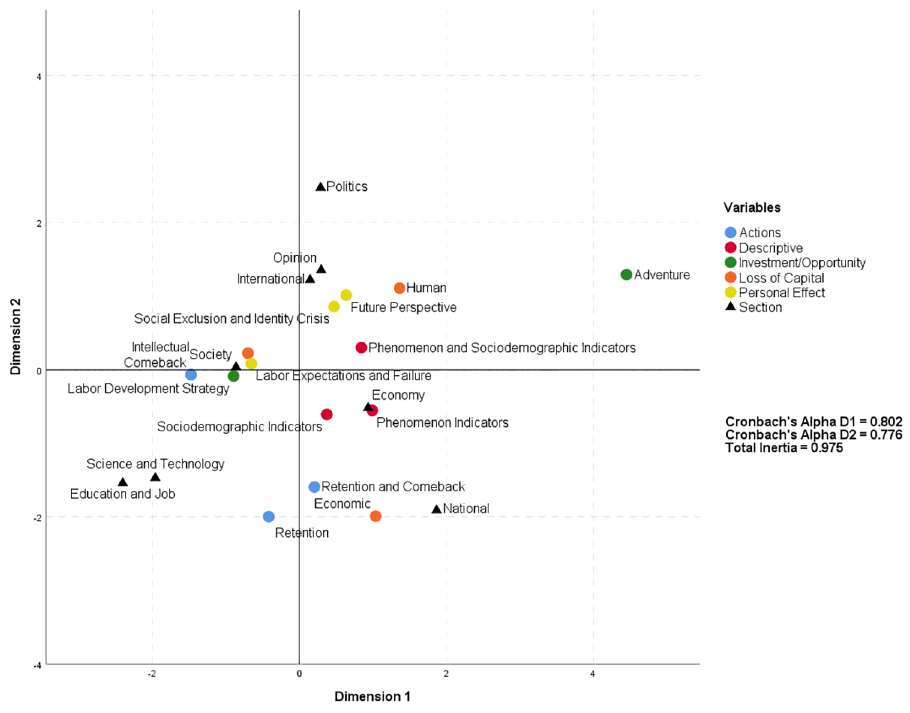
Fig 4. Correspondence analysis of assessment of the phenomenon and